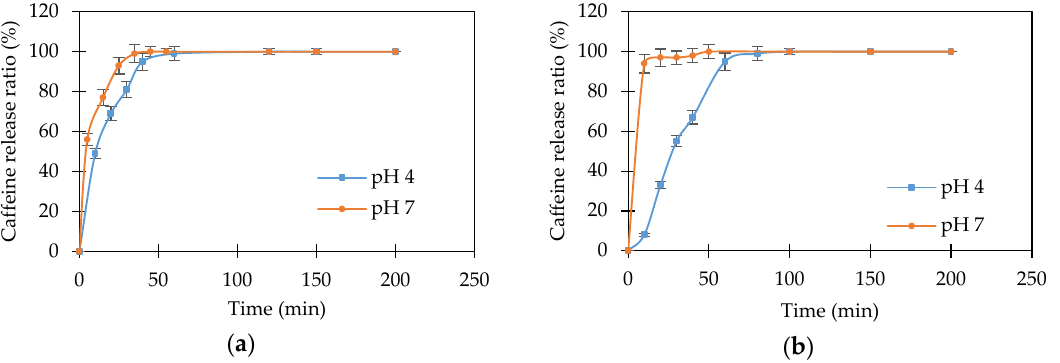
Figure 7. Drug release for ca ff eine into pH 4 and pH 7 bu ff er solution: ( a ) HEMA / AA / AAm; ( b ) HEMA / AA / MBA.